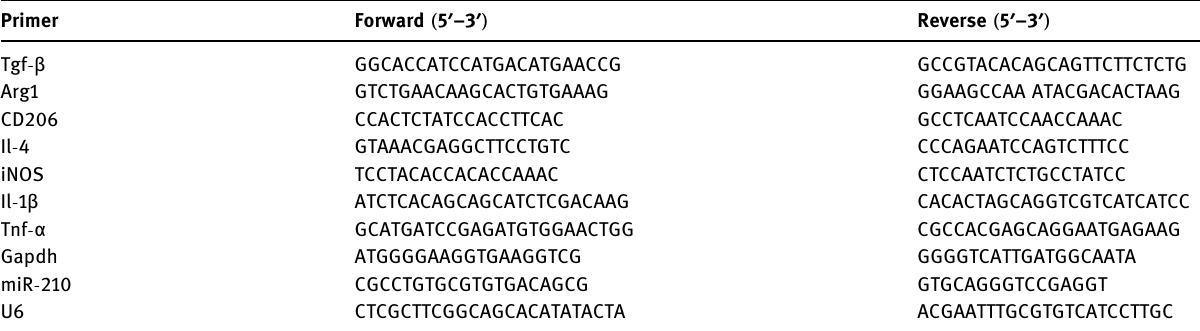
Table A1: Primers used in RT - PCR experiments